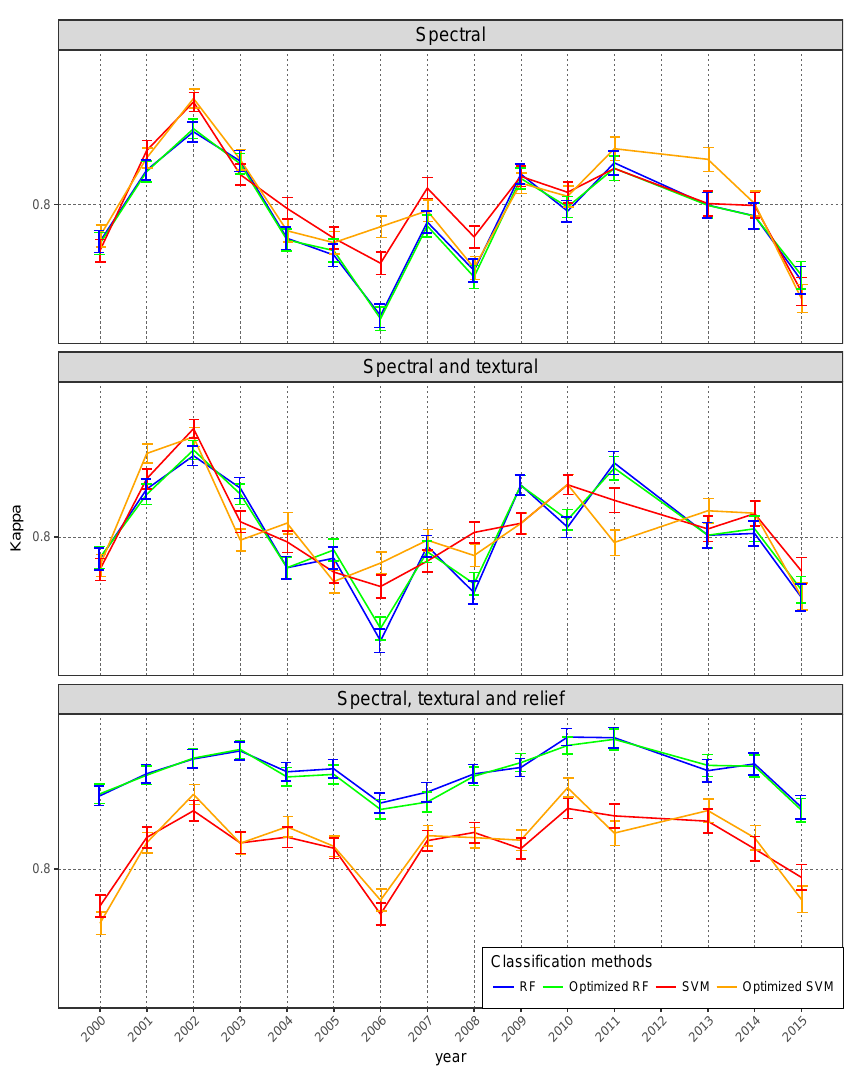
Figure 4. Kappa series with 95% confidence intervals for the RF and SVM algorithms with and without optimization. Number of classifications: